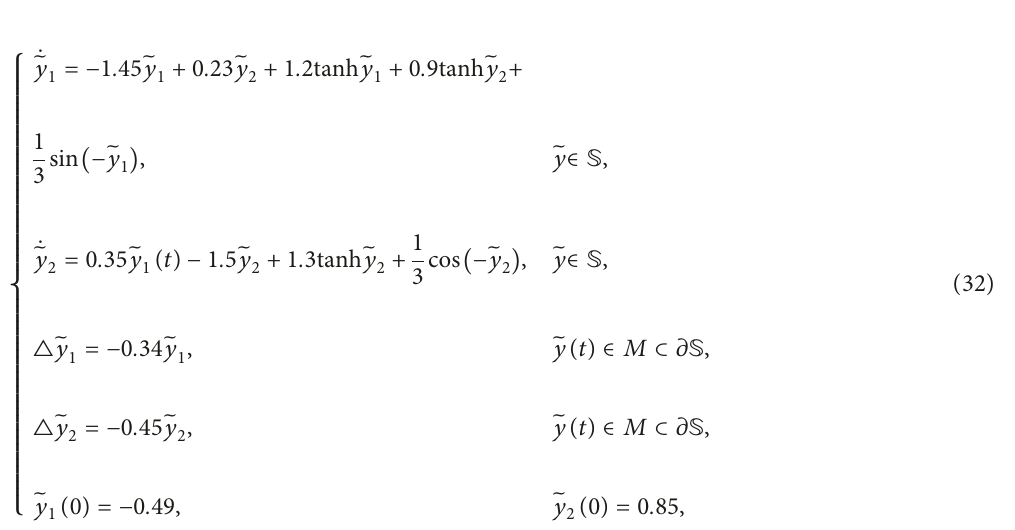
Figure 5: State trajectories z ( t ) for system (4) with